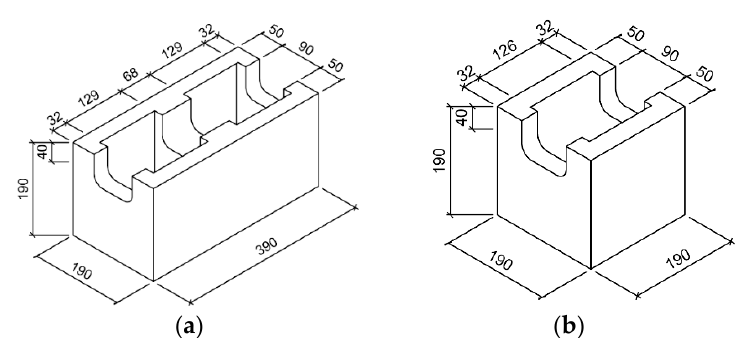
Figure 1. Dimensions of the concrete hollow blocks (mm): ( a ) Full block; and ( b ) half block.